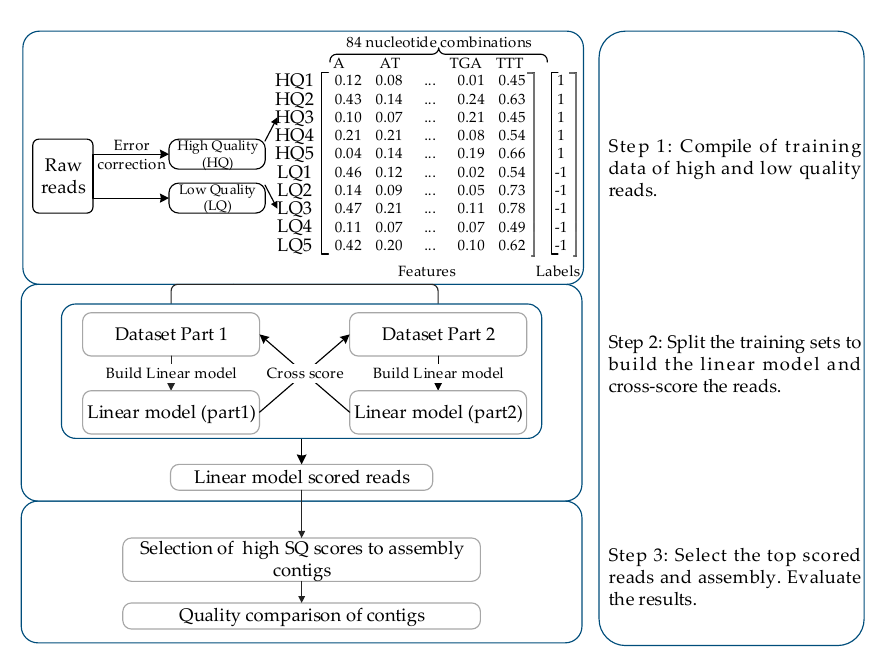
Figure 1. The workflow of the Read Quality Evaluation and Selection Tool (REQUEST). The method consists of three steps: (1) compiling of the training data of high- and low-quality reads; (2) splitting the training set into two parts to build the linear model and cross-score the reads; (3) selecting the top-scored reads and evaluating them. SQ stands for the score of sequencing read quality computed by REQUEST.